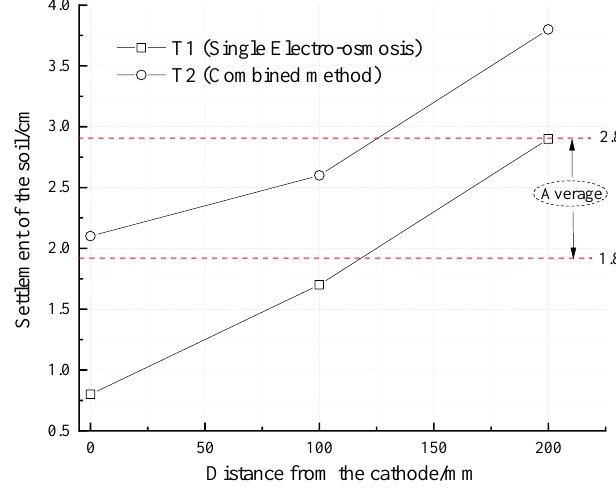
Figure 6. Final soil settlements of T1 and T2.